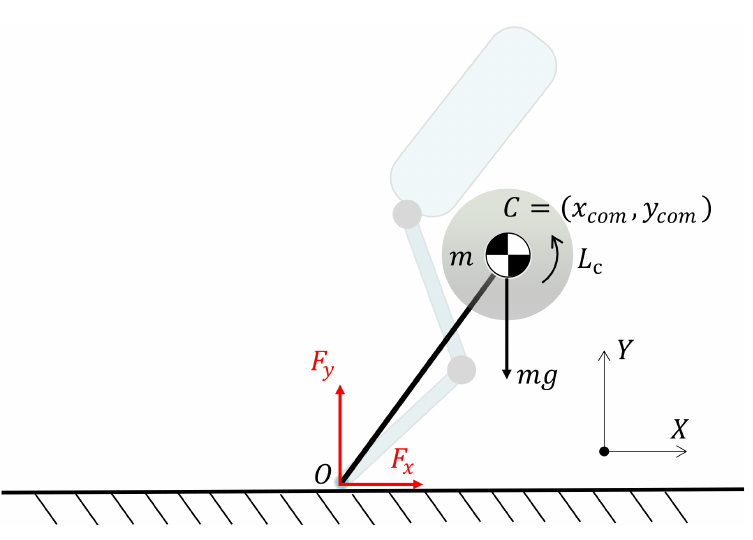
Figure 3. Flywheel inverted-pendulum model of the biped